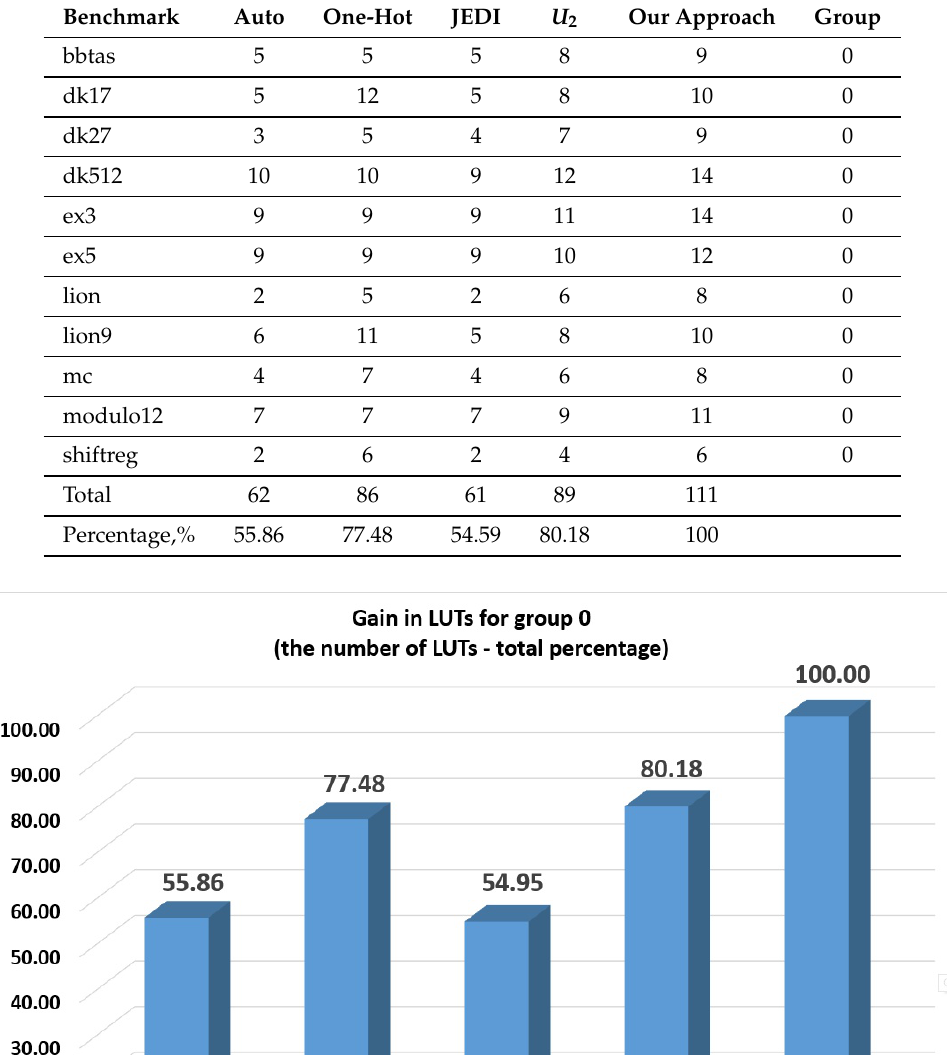
Table 9. Gain in LUTs for group 0 (LUT count).